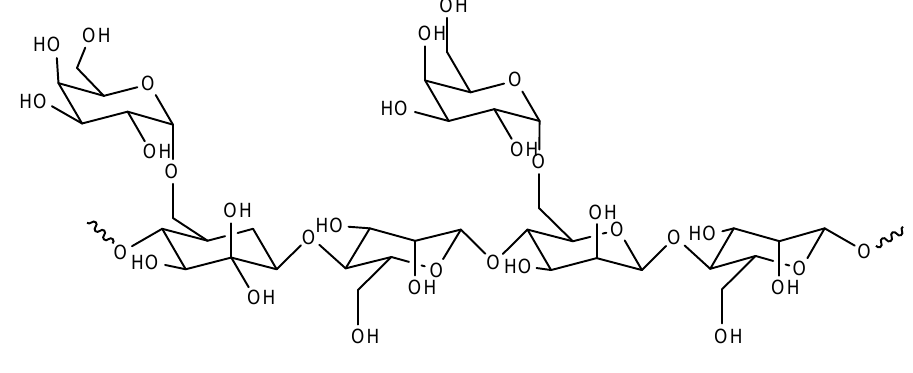
Figure 13. The structure of guar gum.